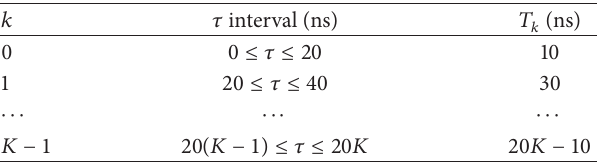
Table 5: The definition of delay interval for elevation pdf condi- tioned on delay.